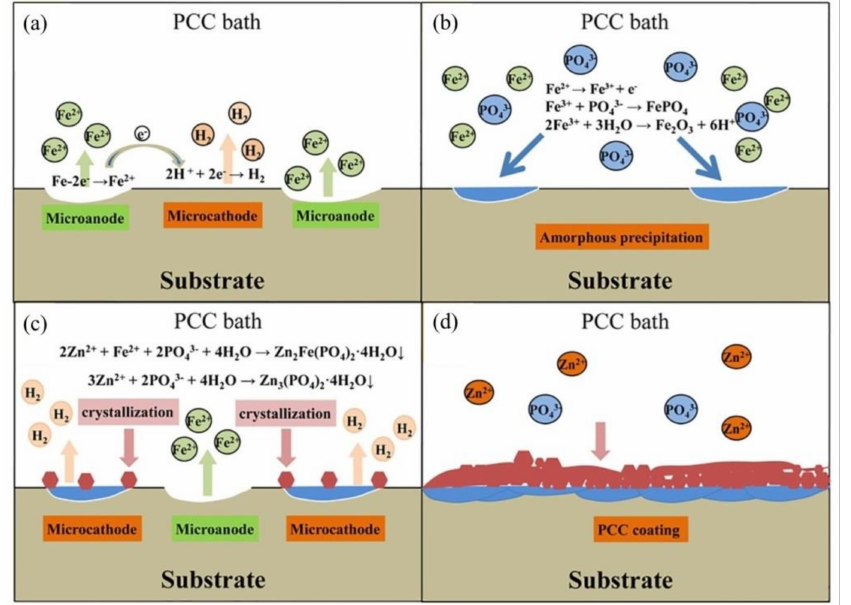
Figure 2. Formation of a phosphate chemical conversion coating: ( a ) microgalvanic couple is established immediately, ( b ) rapid precipitation of amorphous ferric phosphate and ferric oxide on the steel surface, ( c ) insoluble phosphate is deposited and then crystallizes onto the PCC coating on the amorphous base layer, and ( d ) complete PCC coating is formed [33]. Reproduced with permission from Jiang, C. et al., Electrochem. Commun.; published by Elsevier, 2020. By means of XPS analysis, the formation of the amorphous base layer of Fe 2 O 3 and FePO 4 was proven, as seen in Figure 3, where both peaks were recognized in the Fe 2p 3/2 (Figure 3b) and O 1 s (Figure 3d)